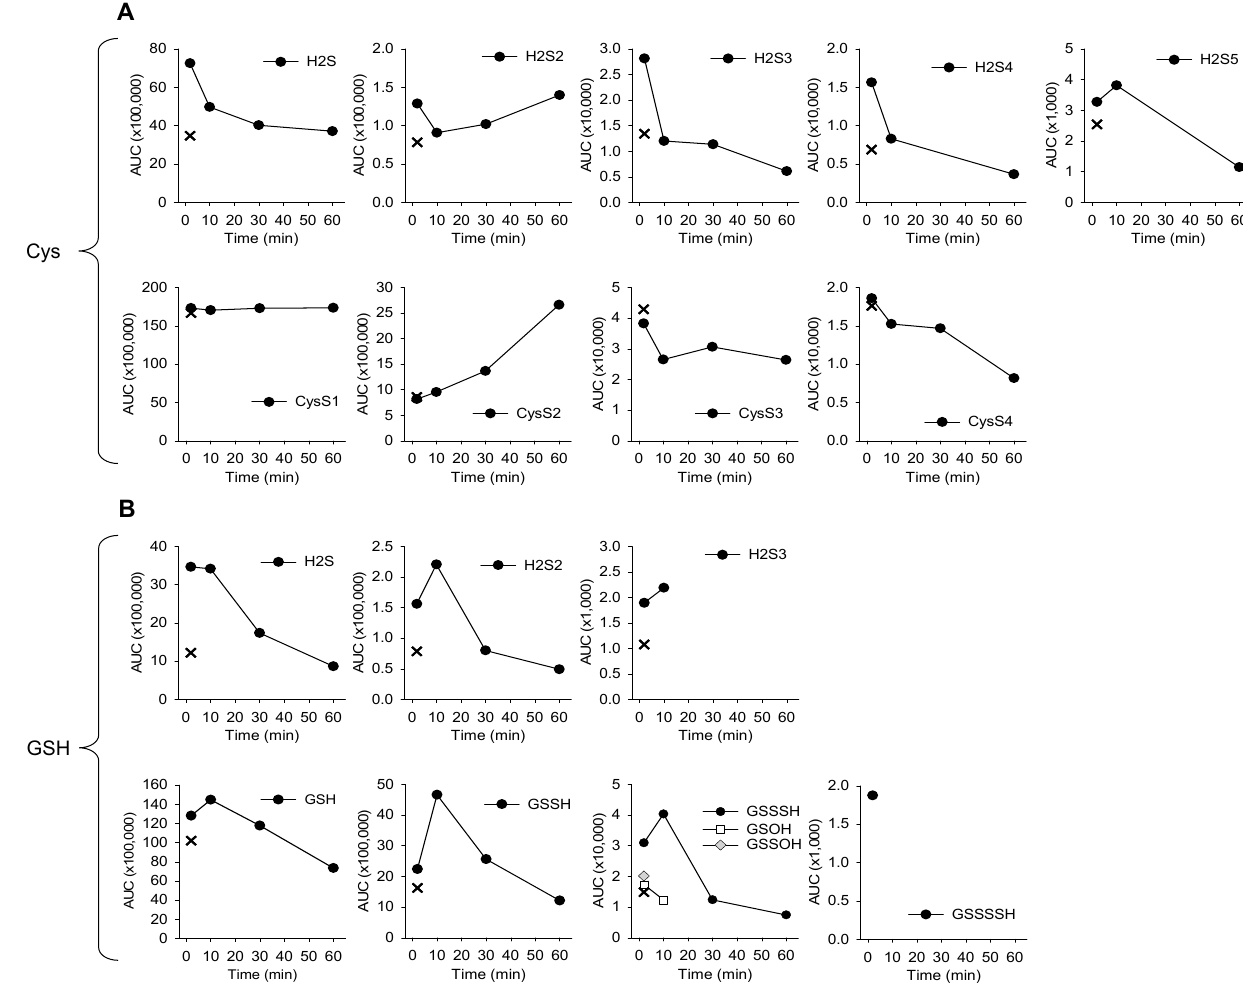
Figure 1. Mass spectrometric evaluation of inorganic and organic sulfur compounds produced by 10 µM 1,4-NQ oxidation of 300 µM H 2 S in the presence of either 1 mM cysteine (( A ); Cys) or 1 mM glutathione (( B ); GSH). Values are expressed as relative area under the curve (AUC). GSH or Cys were added to 1,4-NQ followed by H 2 S. TME-IAM was added at 2, 10, 30, and 60 min and the reac- tions were stopped with 1% formic acid 30 min after the last (60 min) sample and subjected to mass spectrometry. A second aliquot of the 2 min sample was run after the 60 min sample ( ✖ in fi gures) to evaluate the stability of the TME-IAM-sulfur adducts.